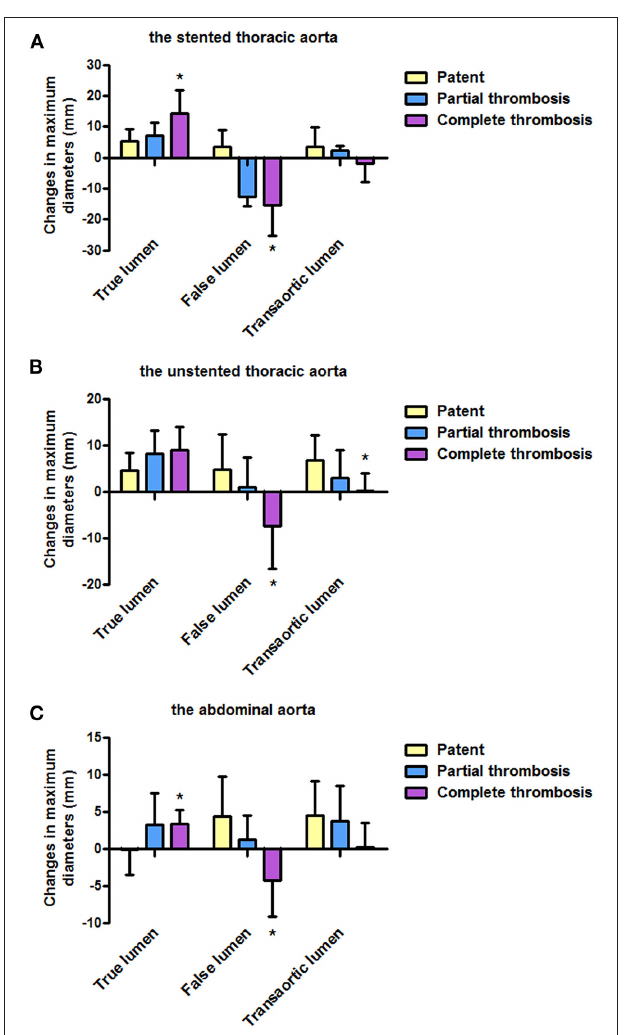
FIGURE 4 | Favorable aortic remodeling after TEVAR for TBAD in the thoracic and abdominal aorta. (A,B) FL was completely thrombosed and regressed, and TL was enlarged on the stented and unstented thoracic aorta in 13 months after TEVAR. (C) The entire thrombosis of FL and the stabilization of TL occurred on the abdominal aorta during a 13-month follow-up. TBAD, type B aortic dissection; TEVAR, thoracic endovascular aortic repair; FL, false lumen; TL, true